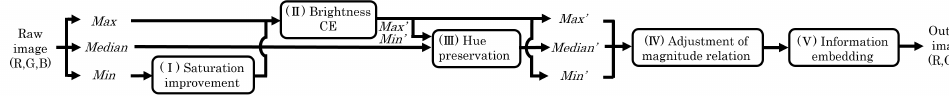
Figure 1. Block diagram of our previous method